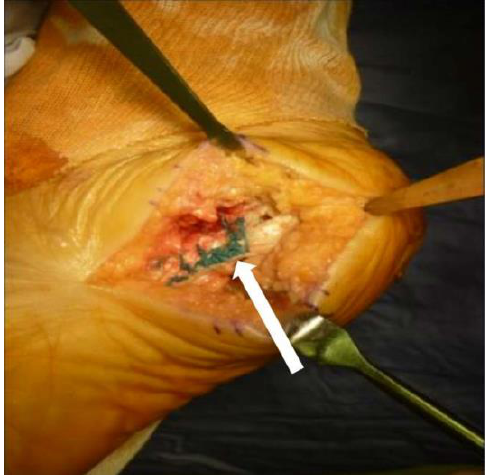
Figure 4. After reconstruction, the 2-0 Ethibond suture was applied to tighten the plantar fascia, as indicated by the white arrow.